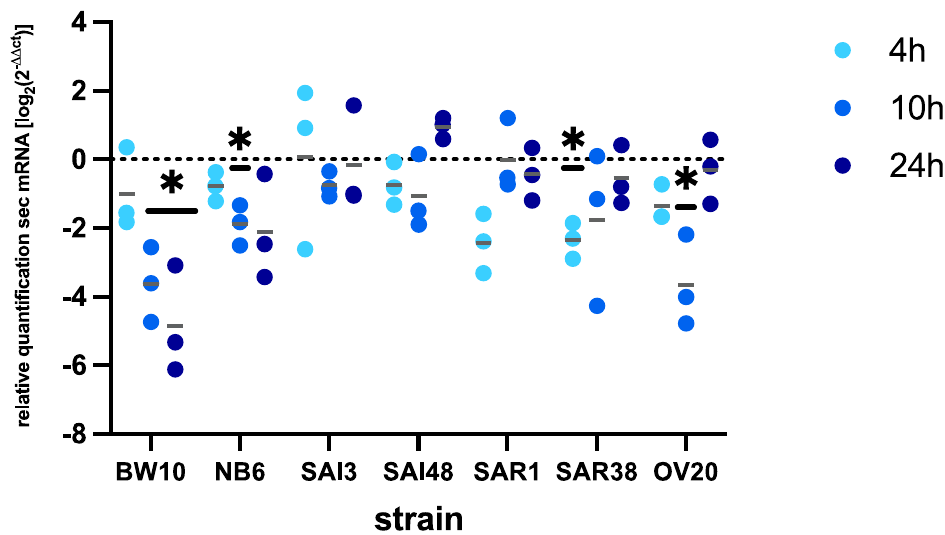
Figure 1. Effect of lactic acid stress on sec mRNA levels in Staphylococcus aureus strains BW10, NB6, SAI3, SAI48, SAR1, SAR38, and OV20 in exponential (4 h), early stationary (10 h), and late stationary (24 h) phase. sec mRNA levels are expressed as relative quantification values. sec mRNA expression was normalized to reference genes rho and rplD [52]. Replicates are shown as single data points; horizontal grey lines indicate means. Timepoints are signified by fill color (4 h, light blue; 10 h, medium blue; 24 h, dark blue). Significant differences in sec mRNA levels in LB compared with LB + lactic acid are marked by asterisks ( p < 0.05).